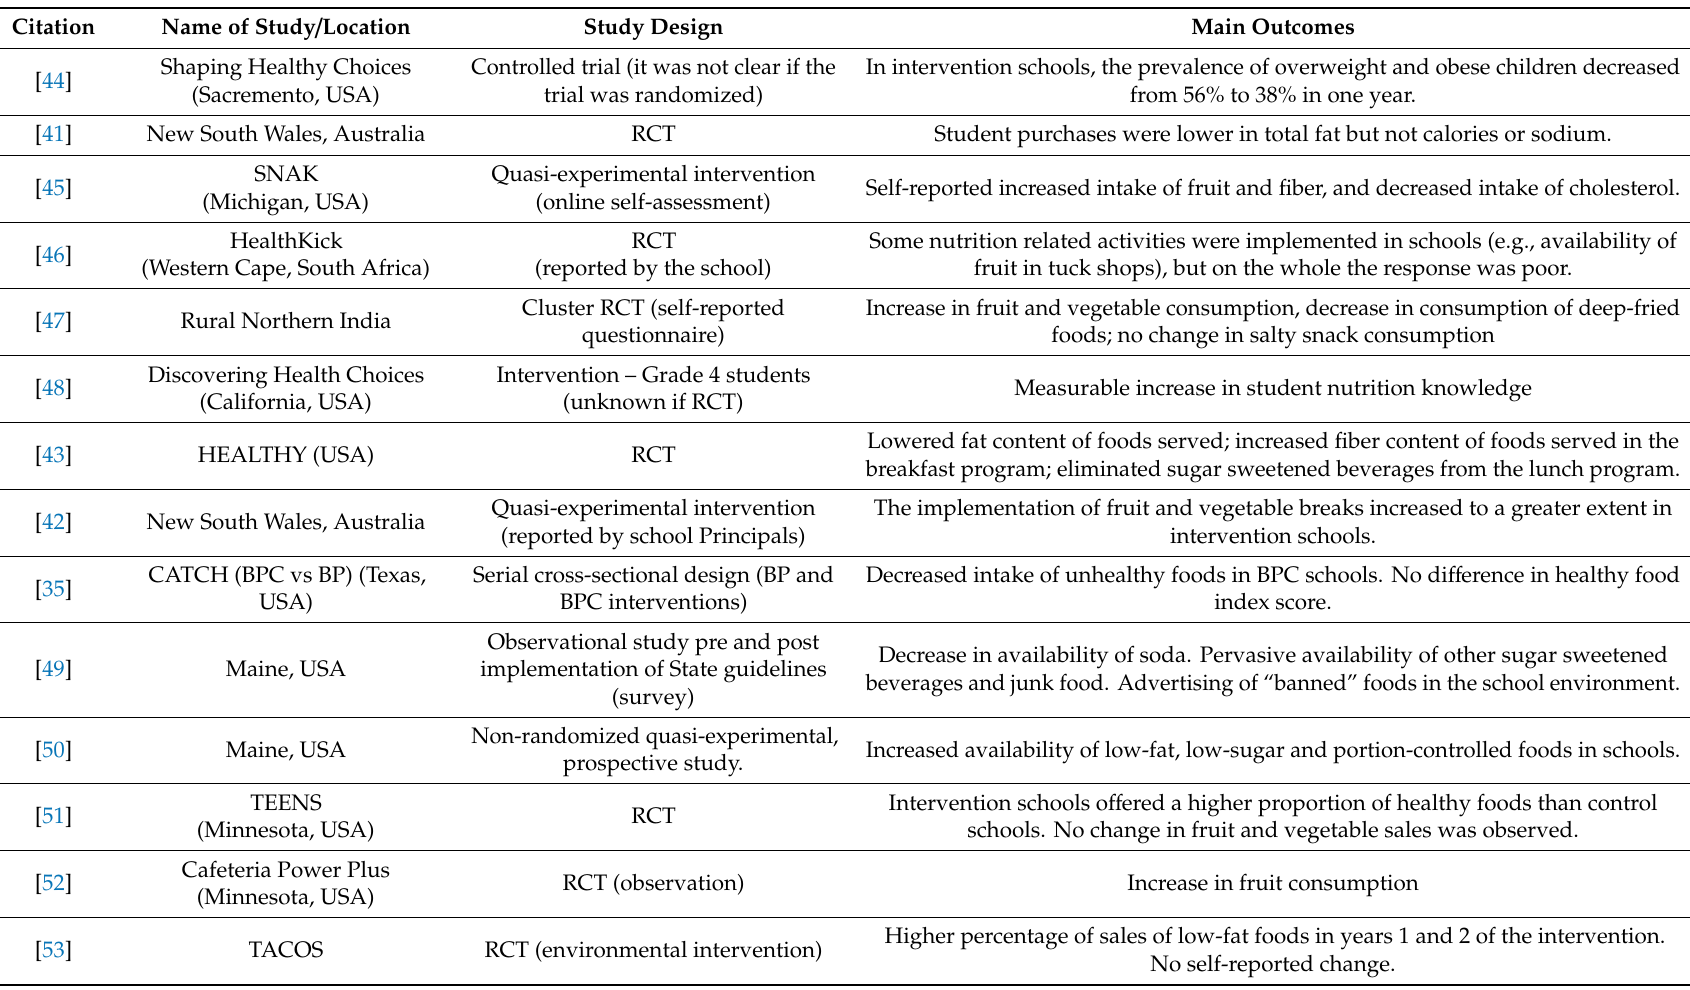
Table 1. Dietary outcomes of nutritional intervention studies that took place in schools since 2000. Findings are presented in chronological order, with the most recent publications listed